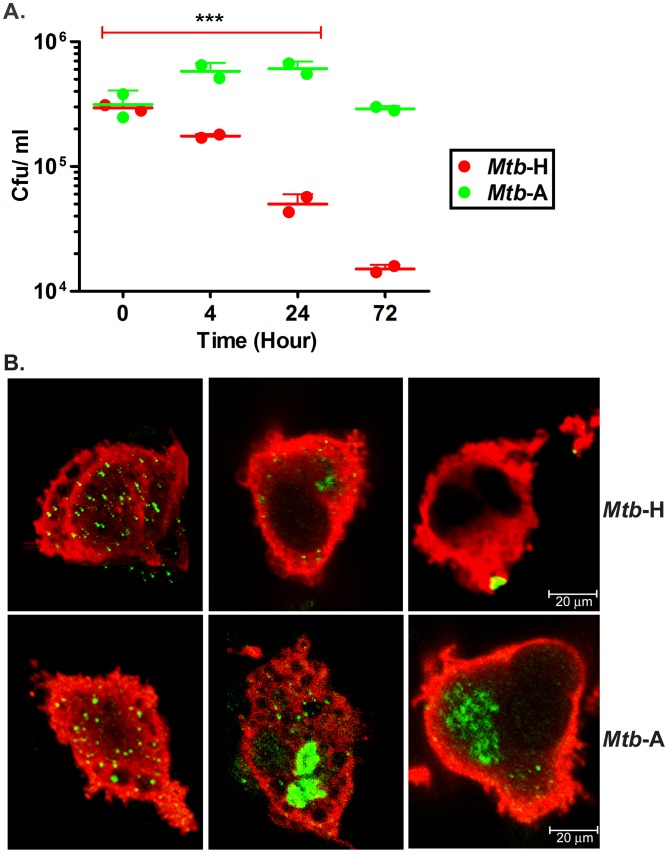
Analysis of the replication of Mtb-A and Mtb-H in Rh-BMDMs.(A) CFU assay. Growth progression of Mtb-A and reduction of Mtb-H during 72 hrs of Rh-BMDM infection measured by CFU analysis is shown. The figure shows the consistent decrease in CFU numbers of Mtb-H (***, p<0.005) at 4, 24 and 72 hrs from two biological replicate experiments, with each replicate data comprising of a summarized value from different relevant dilutions and multiple plating. For Statistics, unpaired Student’s t-test (parametric test) was performed using SAS 9.2 (SA Institute, Cary, NC). (B) Confocal Microscopy. Visual comparison of Mtb (green), Rh-BMDMs (red) at 0 hr, 24 hr and 72 hr post infection. For quantitation, bacilli were counted within Rh-BMDMs (more than 250 Rh-BMDMs in all cases) under a fixed magnification using a TCS-SP2 confocal microscope (Leica Microsystems). Total number of bacilli counted in Rh-BMDMs infected with Mtb-H, Mean±SD were 750±10 at 0 hr; 136±8 at 24 hr; 34±2 at 72 hr and with Mtb-A were 715±20 at 0 hr; 1394±40 at 24 hr; 650±20 at 72 hr. The average relative numbers and SDs determined by CFU assay and Confocal microscopy are shown from at least 3 independent experiments in duplicate or triplicate for each test group.